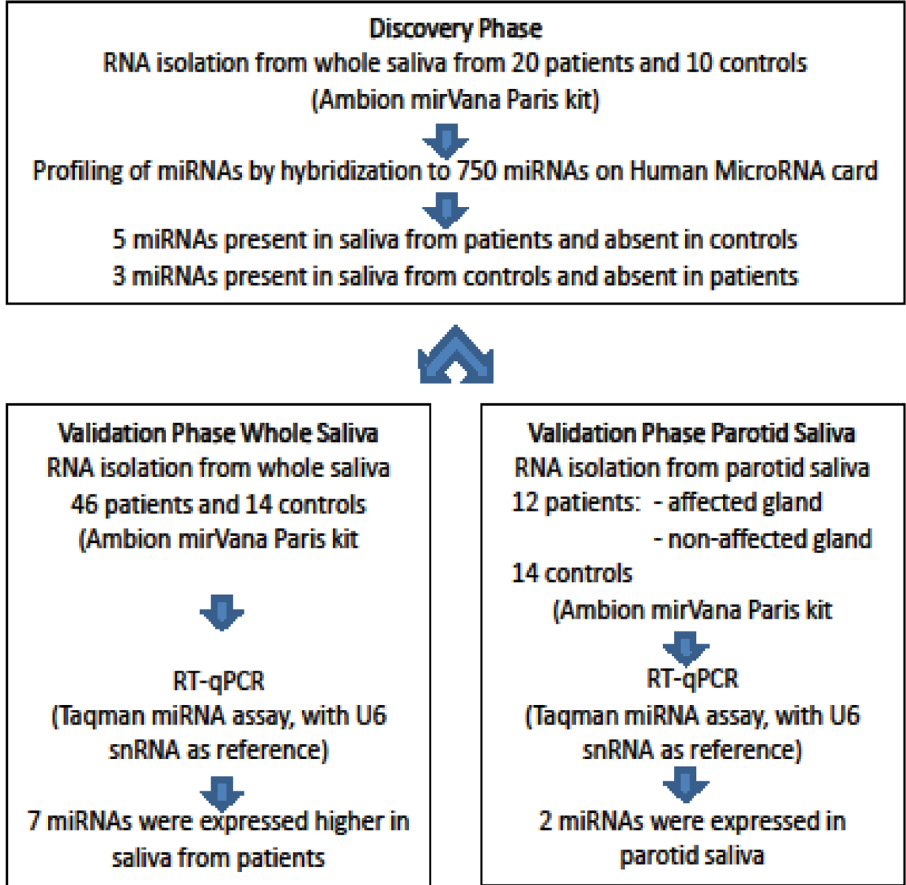
Fig 1. Overview of the research design and saliva samples used in the discovery and validation